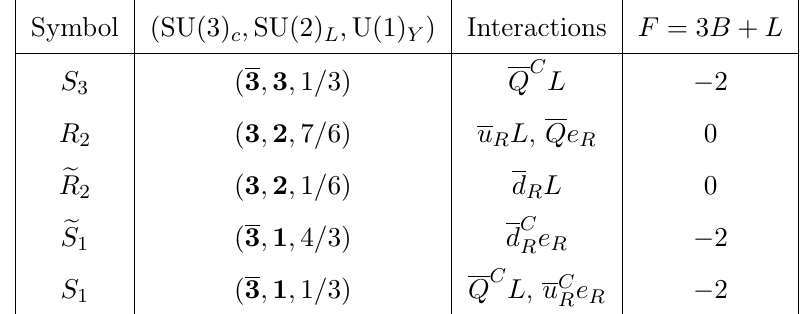
List of all scalar LQs, their SM quantum numbers, renormalizable interactions to the quark-lepton pairs, and associated fermion numbers. Interactions with right-handed neutrinos are not considered.